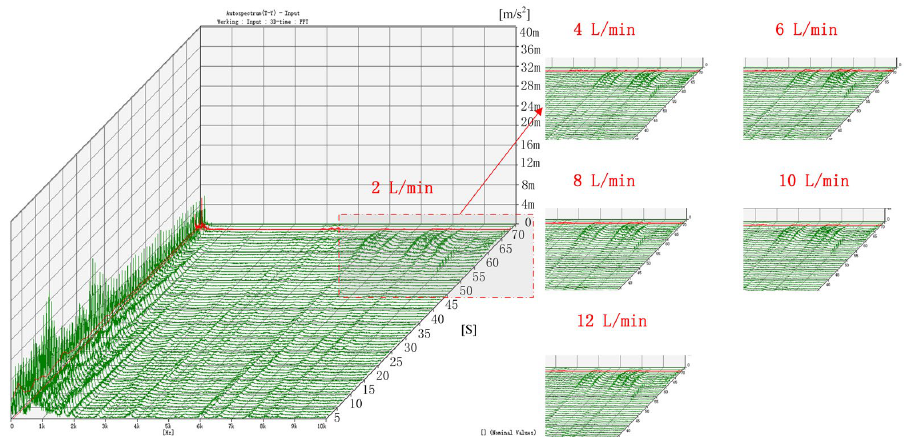
Figure 11. Effect of the flow rate on the frequency-domain diagram of the test bearing in the Y di- rection.